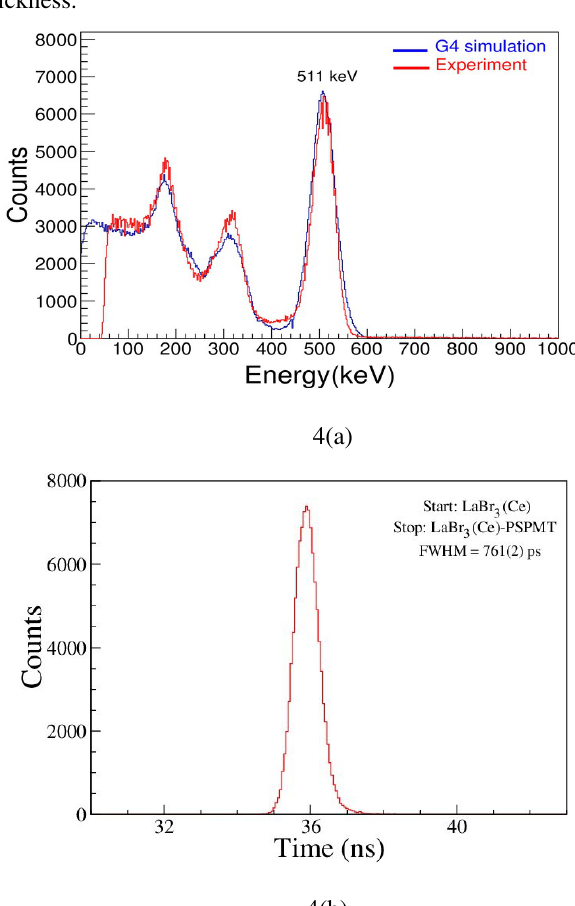
Fig. 4. a) Simulated and experimental gamma-ray energy spectra of 22 Na source for the LaBr 3 Ce)-PSPMT detector obtained in coincidence with 511 keV γ-energy in the BGO spectrum. The calculated energy resolution of the 511 keV photo-peak is 6%. b) TAC spectrum, with the timing from the ∼ auxiliary cylindrical LaBr 3 (Ce) taken as the START signal, and that from the position sensitive detector as the STOP